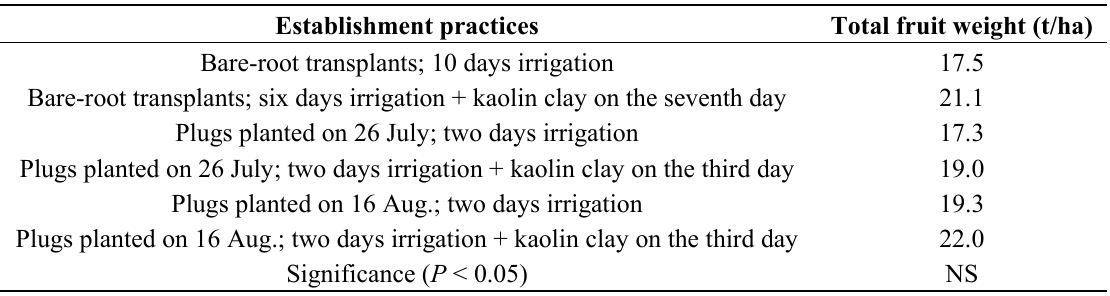
Table 2. Total fruit weight of strawberry from different transplant types and establishment practices in Balm, FL, USA, during the 2010–2011 season. Transplant types were bare-root and containerized (plug) plants, and establishment practices were 10 days of sprinkler irrigation, six days of sprinkler irrigation plus kaolin clay on the seventh day, two days of sprinkler irrigation, and two days of sprinkler irrigation plus kaolin clay on the third day. NS = non-significant at P < 0.05.